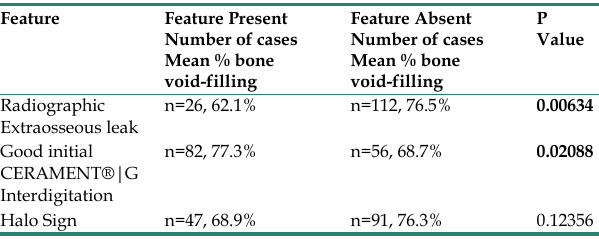
Table 6. Mean percentage bone void-filling at final follow-up when compared to the presence or absence of various